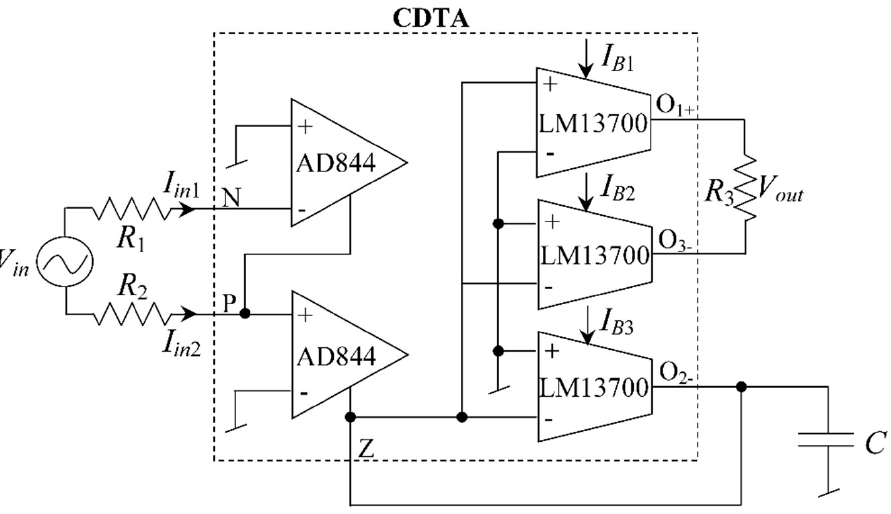
Figure 11. Practical implementation of the proposed fully differential LP filter.